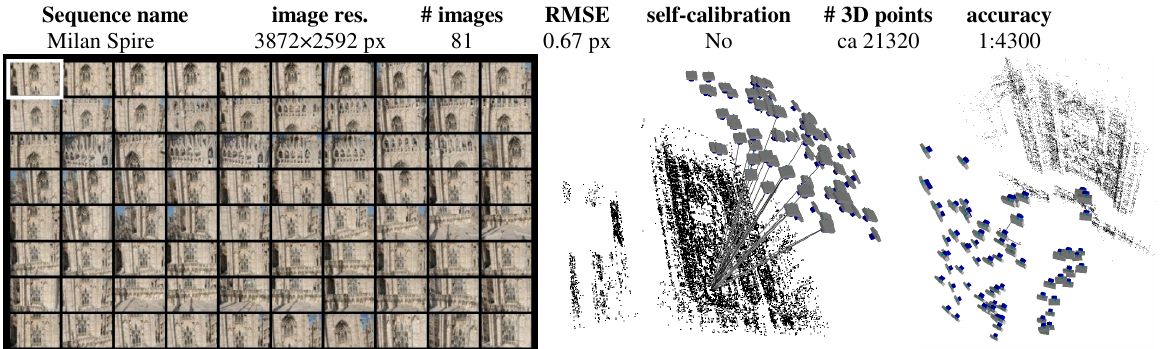
Figure 4: Example of unordered image